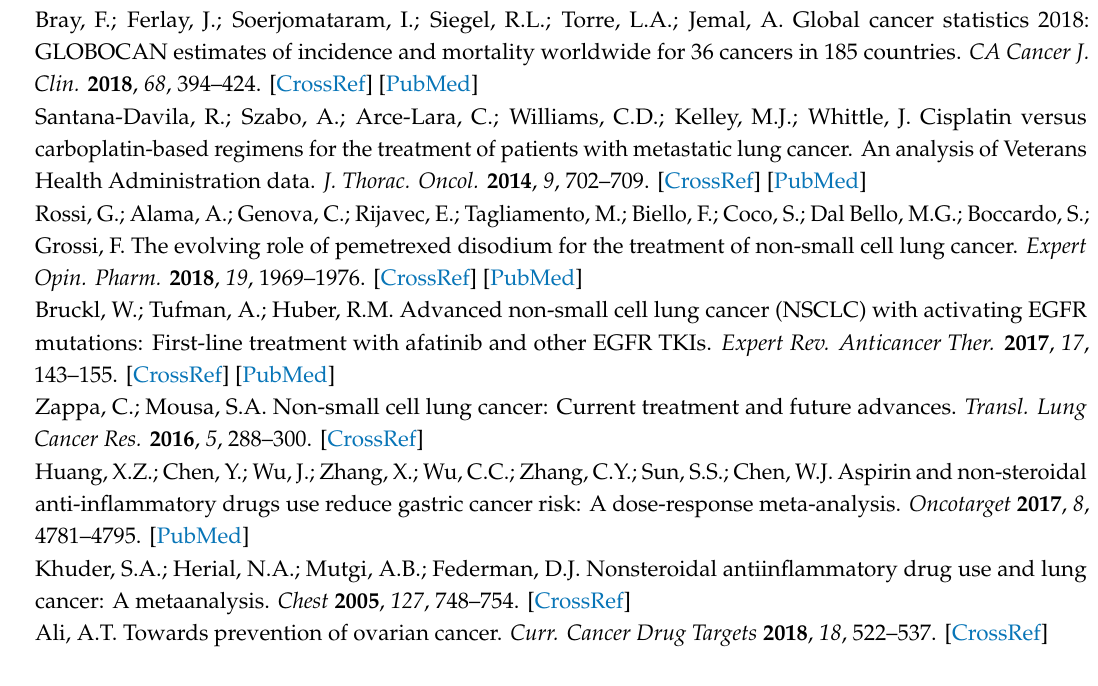
Supplementary Materials: The following are available online. Figure S1: E ff ect of NO-aspirins on the viability and proliferation of non-small-cell lung cancer (NSCLC) cells; Figure S2: Concentration–response curves of aspirin, NO-aspirins, and erlotinib on viability of non-small-cell lung cancer (NSCLC) cells; and Figure S3: E ff ect of NO-aspirins combined with erlotinib on the viability of non-small-cell lung cancer (NSCLC)